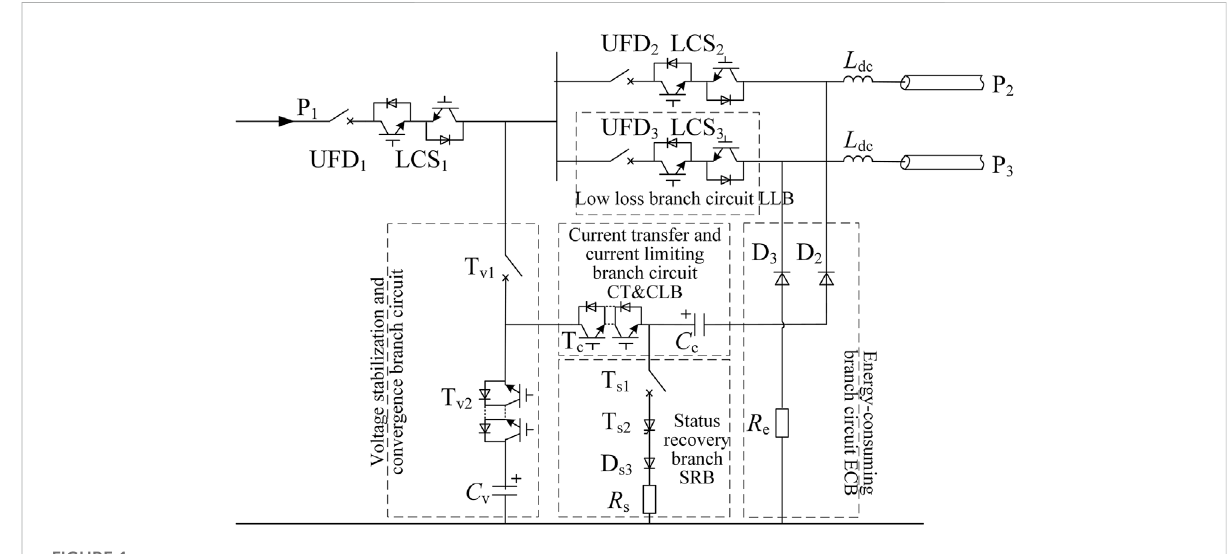
FIGURE 1 DC CL and EC MP-DCCB topology structure.